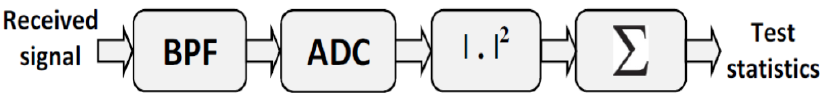
Figure 2. Digital energy detector